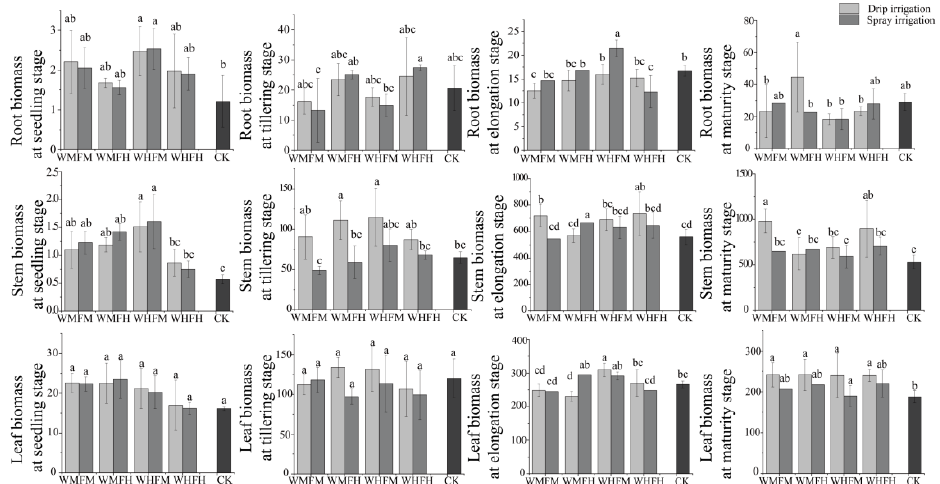
Figure 2. Biomass in roots ( top panels), stems ( center ), and leaves ( bottom ) of sugarcane in (left to right) the seedling, tillering, elongation, and maturity stages under different water-fertilizer treatments (for treatment abbreviations, see Table 1) (Different letters a, b, c and d in the figure indicate significant differences between treatments).